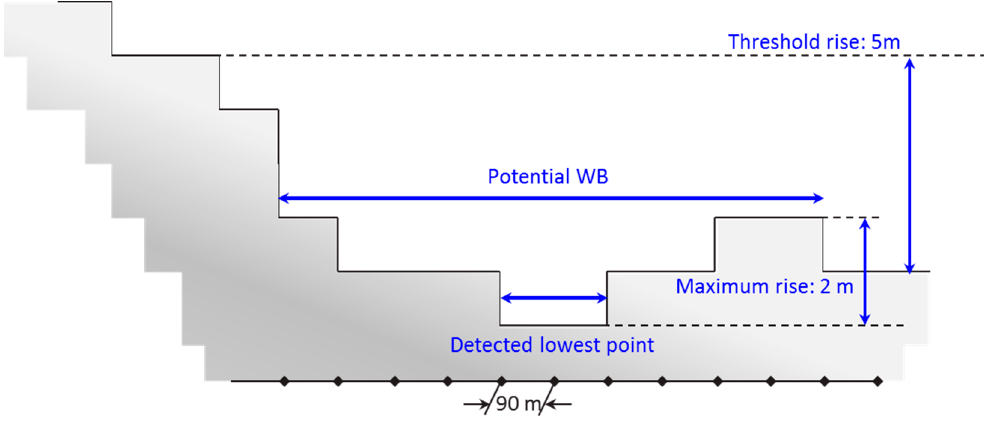
Figure 2. Expanding the initially detected lowest point by systematically rising an imaginary water level in steps of 1 m. The corresponding 90 m spatial resolution pixels are indicated by the dots at the bottom.